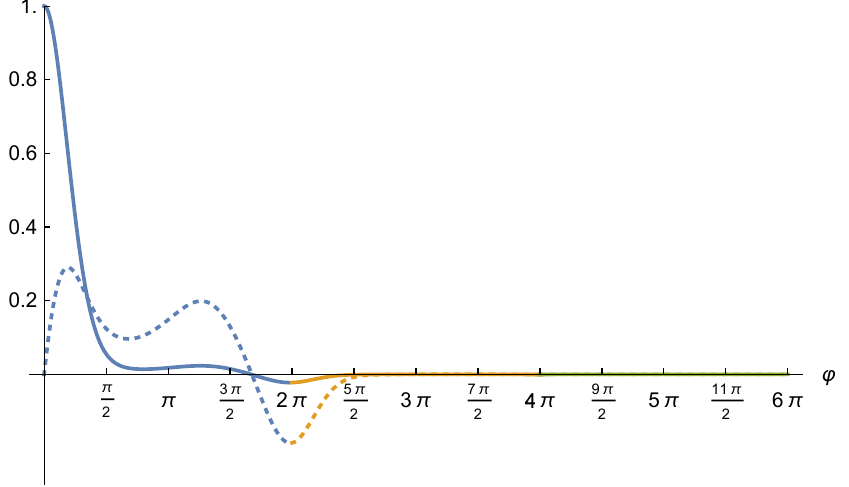
Figure 4. (Numerical approximations to the) particular solutions of la Cierva’s equation after the first three turns of the autogiro’s blade (c.f. Equations (47) and (48)). The blue lines represent the curves of both particular solutions at the first turn, the orange lines correspond to their prolongations to the second turn of the blade, and the green lines depict the extensions of such solutions to the third turn. As with Figure 3, the dotted line corresponds to y 2 ( ϕ )